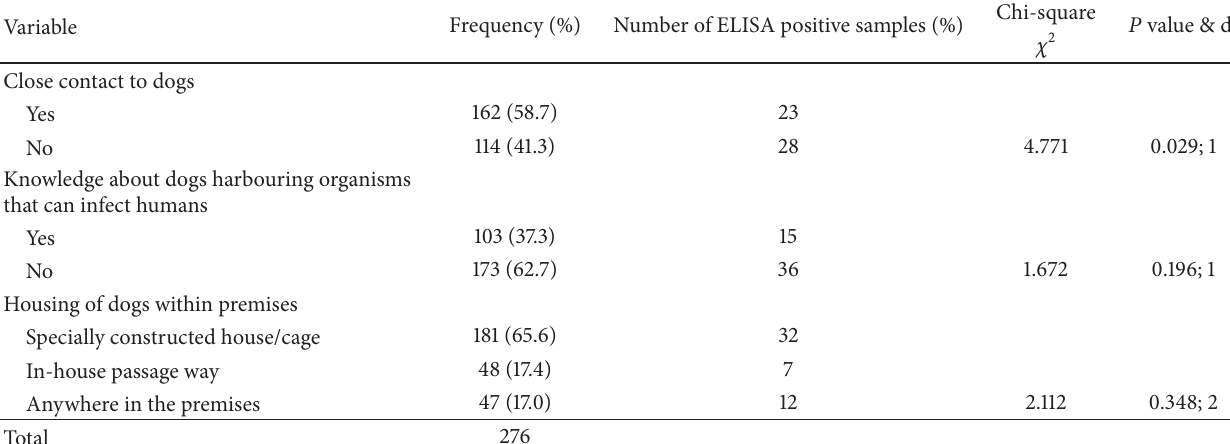
Table 7: Factors associated with the prevalence of Cryptosporidium infection in dogs within sampled households in the FCT, Abuja. Variable Close contact to